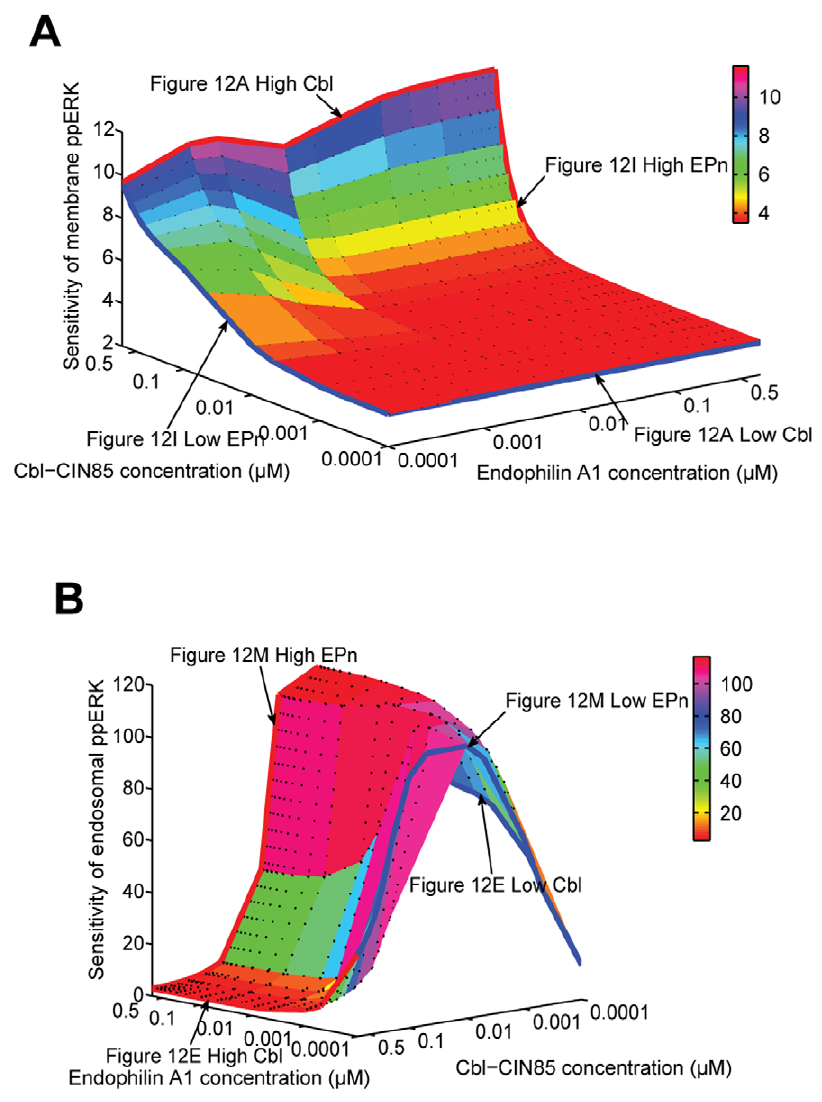
Figure 10. Differential sensitivity of ppERK from (A) membrane and (B) endosomal subpathways for EGF under various Cbl-CIN85 and Endophilin A1 concentrations when both scaffold proteins KSR and MP1 are expressed at sub-optimal ‘‘low’’ levels. For clarity, the sensitivity levels are denoted by colors in the scale bars. Arrows indicate response curves under the conditions specified and detailed in Figure 12, Panels A, E, I, M. ( Figure 12 ), and (4) when MP1 is present at ‘‘high’’ level [0.3 m M] and KSR is at ‘‘low’’ level [0.02 m M] ( Figure 12 ). Results of sensitivity analyses in Supplementary Figure S5 show that the MP1-scaffolded module bears little sensitivity in response to varying EGF doses under condition (1) when both scaffolds are present in suboptimal ‘‘low’’ levels [KSR = 0.02 m M, MP1 = 0.02 m M].